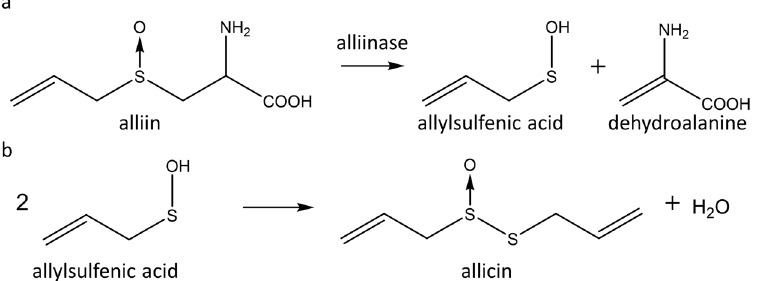
Figure 1. Biosynthesis of allicin from S-allyl cysteine sulfoxide (alliin). The enzyme alliinase (a C-S lyase, E.C. 4.4.1.4.) catalyzes the formation of allylsulfenic acid and dehydroalanine ( a ), whereupon two molecules of allylsulfenic acid condense spontaneously to yield one molecule of allicin ( b ).